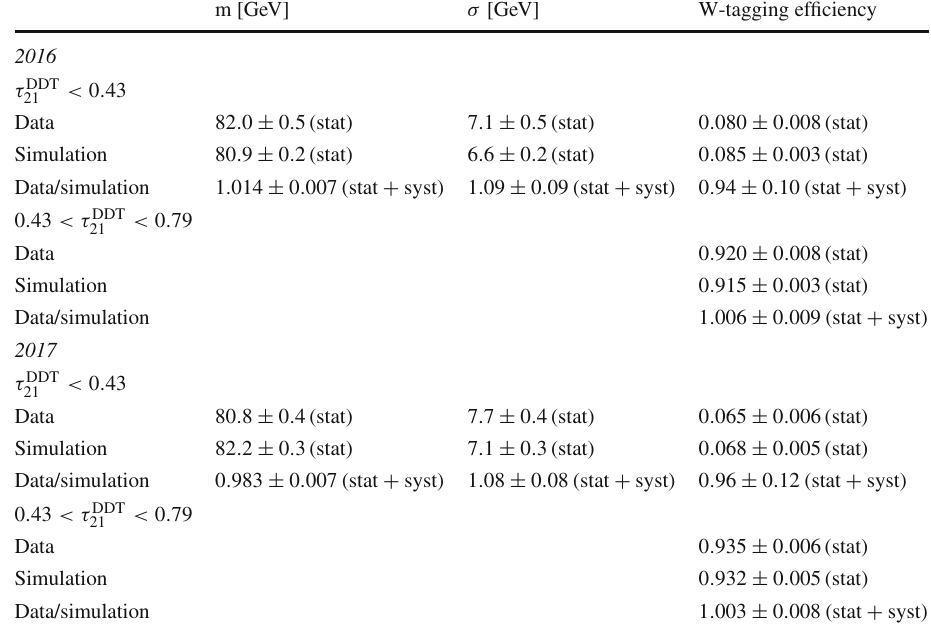
Table 1 The W jet mass peak position (m) and resolution ( σ ), and the W-tagging efficiencies, as extracted from top quark enriched data and from simulation, together with the corresponding data-to-simulation scale